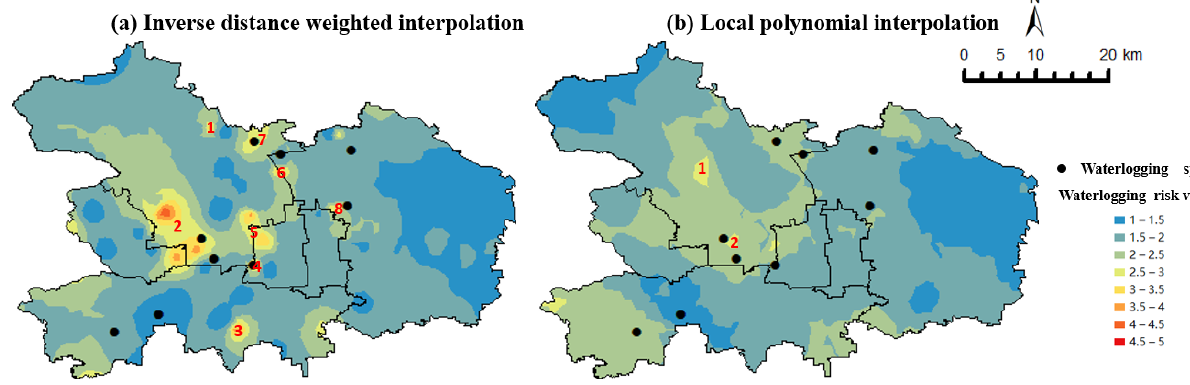
Figure 6. Annotation of the waterlogging points on the risk assessment